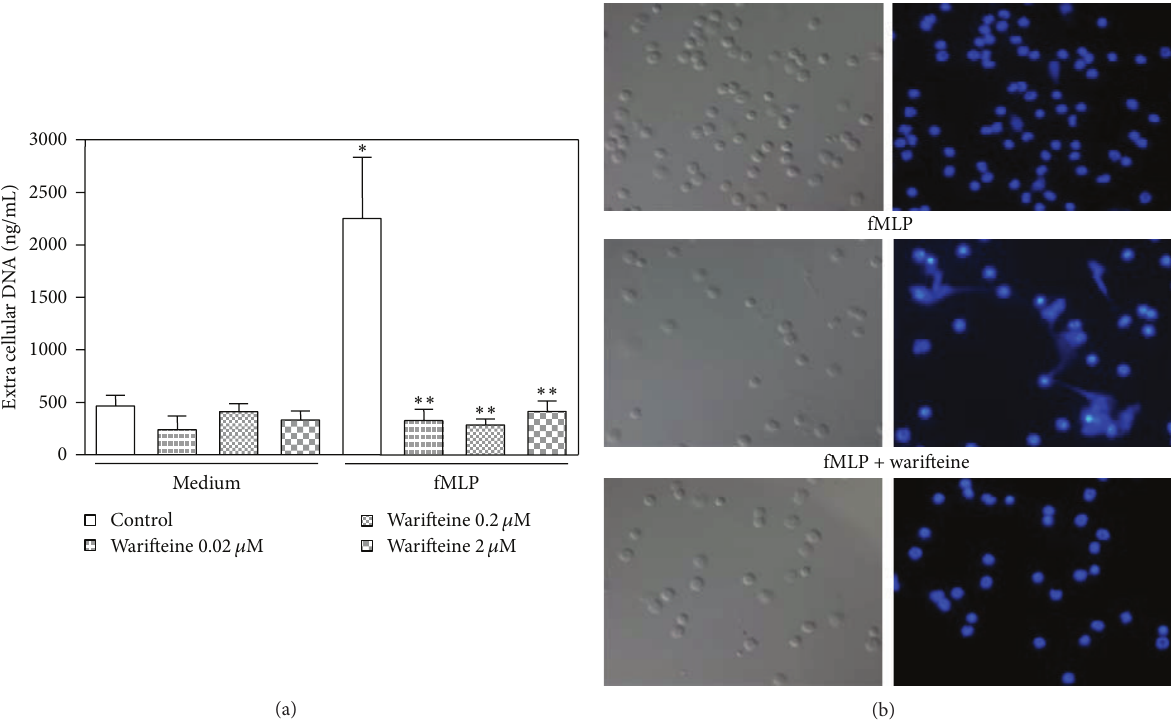
Figure 8: Extracellular DNA traps (NETs) induction in warifteine-treated neutrophil cultures. (a) Neutrophils were preincubated with the indicated doses of warifteine. The cells were then stimulated with fMLP. The supernatants were then harvested and the amount of extracellular DNA was measured. (b) Neutrophils were transferred to coverslips, treated with warifteine (2 𝜇 M), and then stimulated with fMLP. The coverslips were fixed and stained with DAPI. This was followed by analysis by phase contrast and fluorescence microscopy. Plots show representative fields recorded in light (right) and dark (left) fields where DAPI labeling was determined. Data are representative of three independent